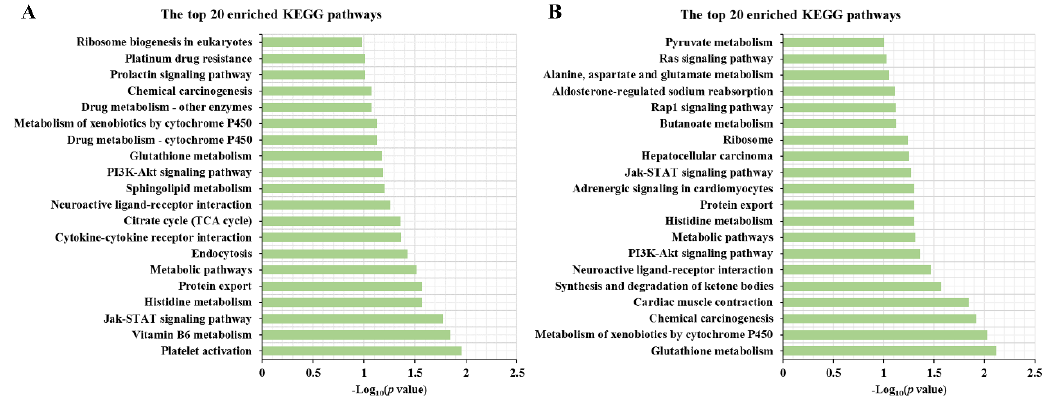
Figure 9. The top 20 KEGG pathways enriched by key genes/proteins in PF vs. MF ( A ) and PL vs. ML ( B ).